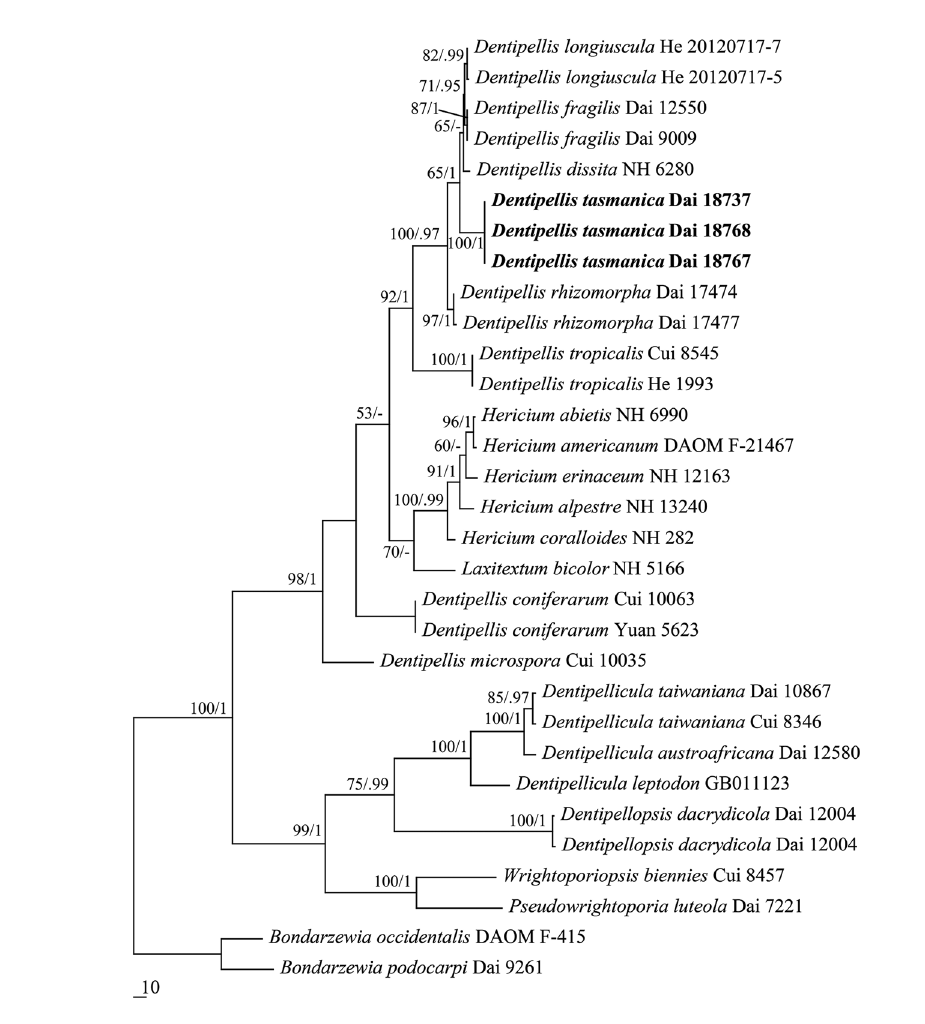
Figure 1. Strict consensus tree illustrating the phylogenetic position of Dentipellis tasmanica , generated by the maximum parsimony method based on ITS+28S sequence data. Branches are labelled with parsi- mony bootstrap values ≥50% and Bayesian posterior probabilities ≥0.95. Bondarzewia podocarpi and B. oc- cidentalis are used to root the tree. Branch lengths reflect expected changes per site as indicated by the